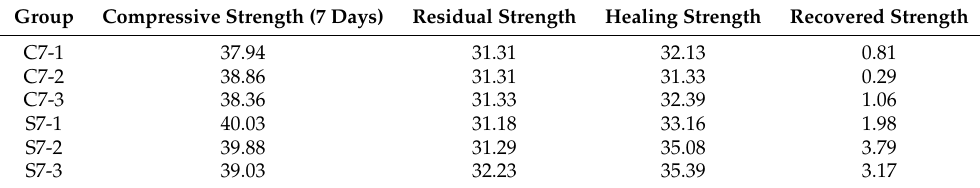
Table 3. Compressive strength of the two ECC mixtures recovered after early curing (7 days). (unit: MPa).